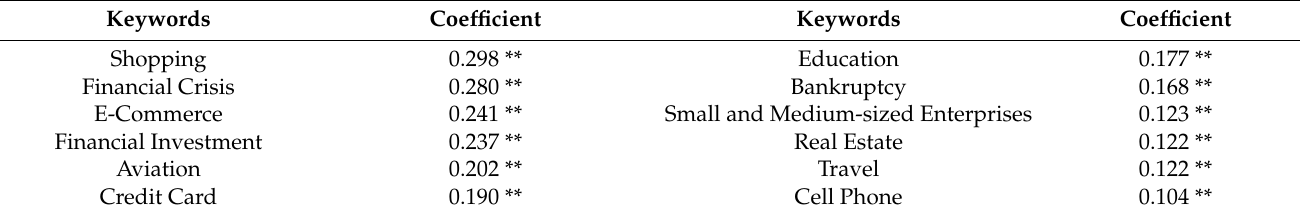
Table 11. Keywords selected by the cross-correlation